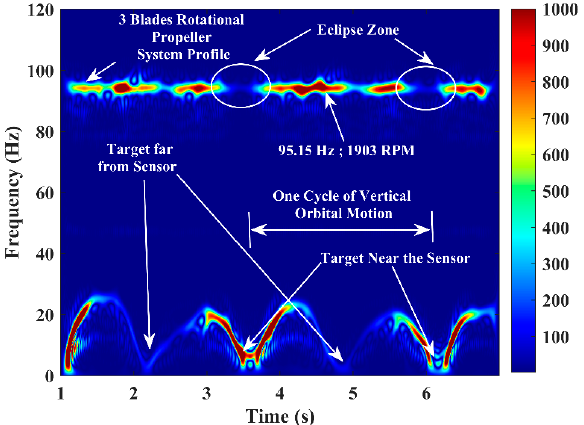
Figure 10. Micro − Doppler signature/pattern image designed using the improved SP − WVD for the simultaneous activities of two targets: a three − blade rotational propeller system and a circular vertical path kinetic warhead’s orbital motion.